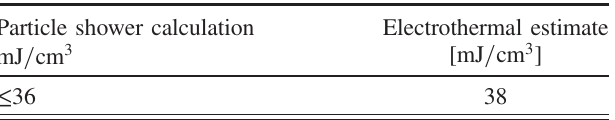
TABLE I. Quench-level comparison; FLUKA upper bound and the electrothermal MQED estimate for the strong-kick event. Particle shower calculation